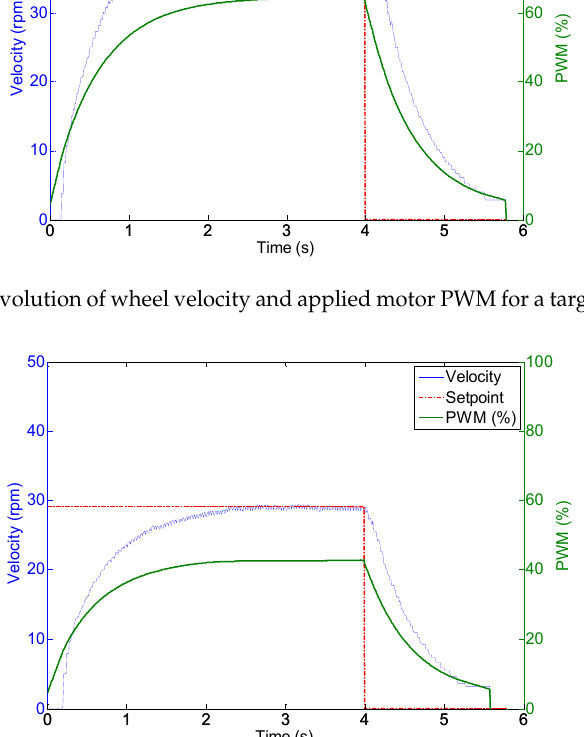
Figure 23. Wheel 2. Evolution of wheel velocity and applied motor PWM for a target velocity of 29 rpm.